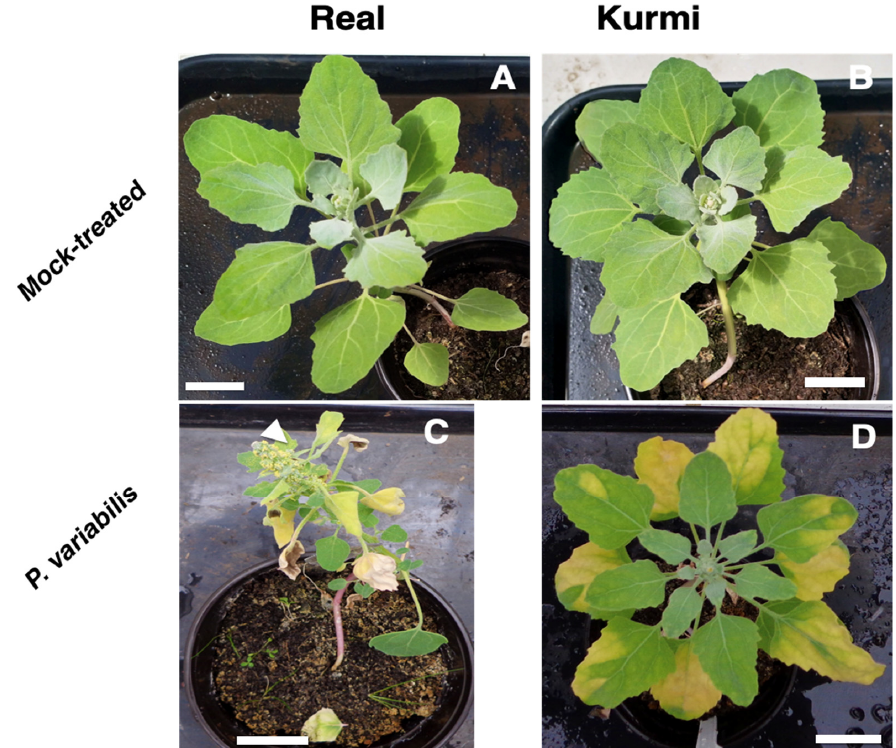
Figure 4. Six-week-old quinoa plants 21 days after infection with P. variabilis . The figure shows symptoms of downy mildew disease in quinoa cv. Real ( C ) and cv. Kurmi ( D ), as compared to mock-treated controls ( A and B , respectively). The images are representatives of two independent experiments with three biological replicates each. The white arrowhead points at the early flowering observed in the infected Real cultivar.